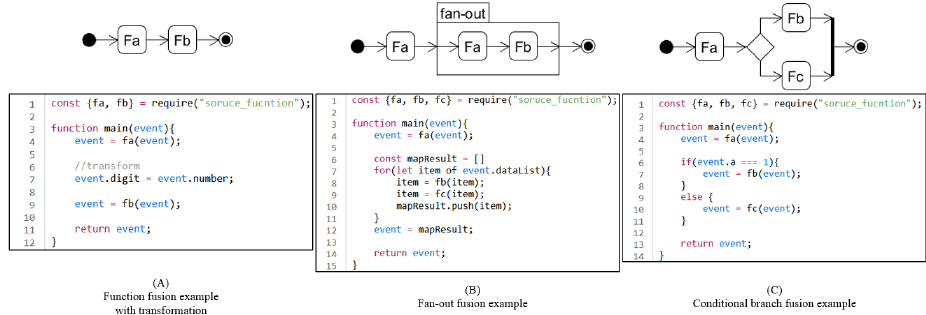
Figure 7. Example to show how to write fused function in JavaScript. ( A ) shows the case of two functions. ( B ) shows the case of a fan-out. ( C ) shows the case of a conditional branch.